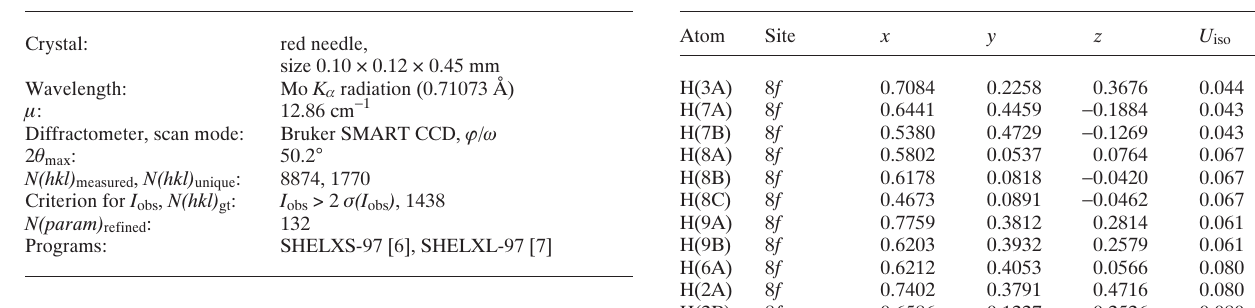
Table 2. Atomic coordinates and displacement parameters (in Å 2 ) . Table 1. Data collection and